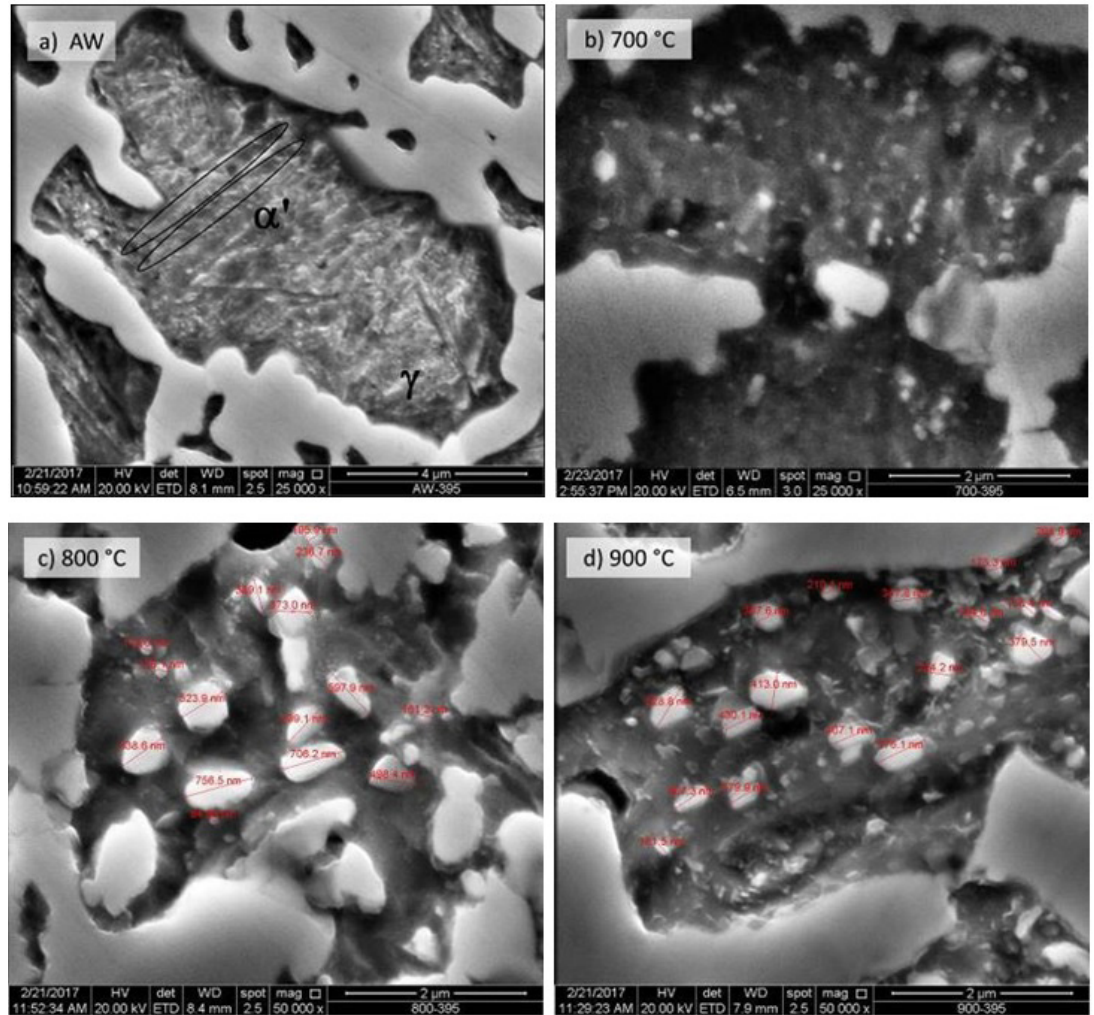
Figure 4. Evolution of the eutectic phase a) AW, b) 700, c) 800 and d) 900